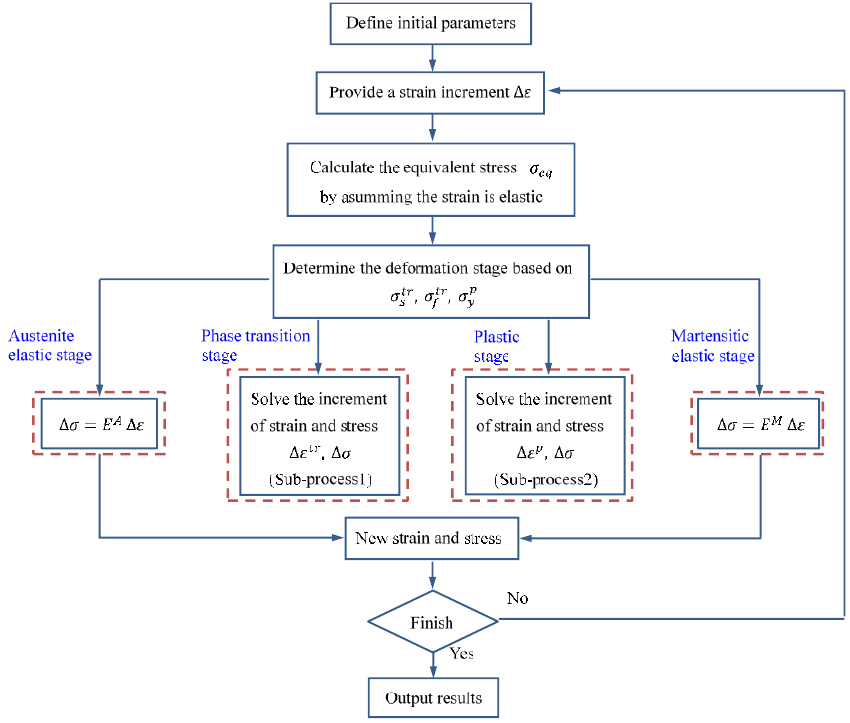
Figure 1. Flow chart of the iteration solution.